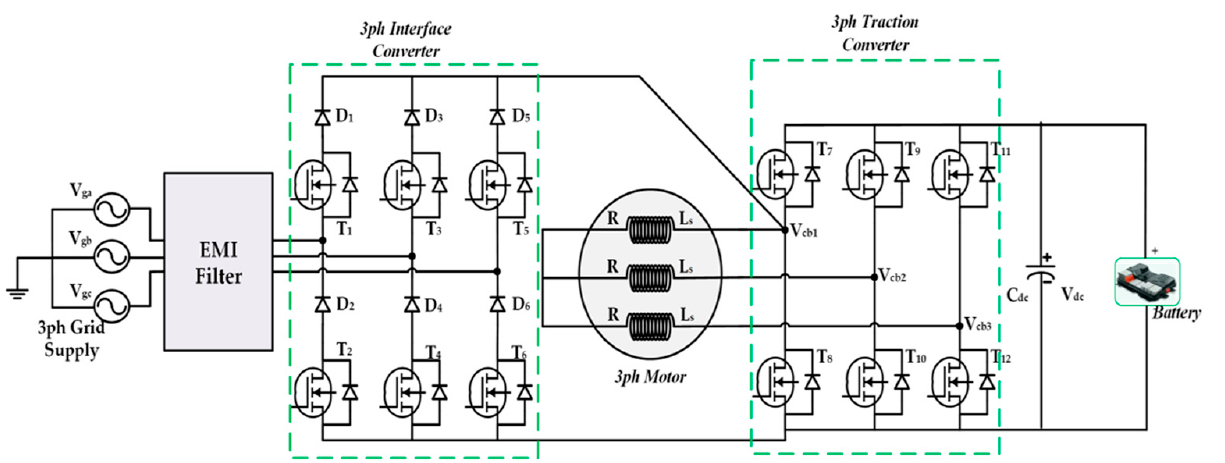
Figure 11. Three Phase integrated on − board charger with interface converter proposed by Shi et al. [70] in 2018. (iOBC7).